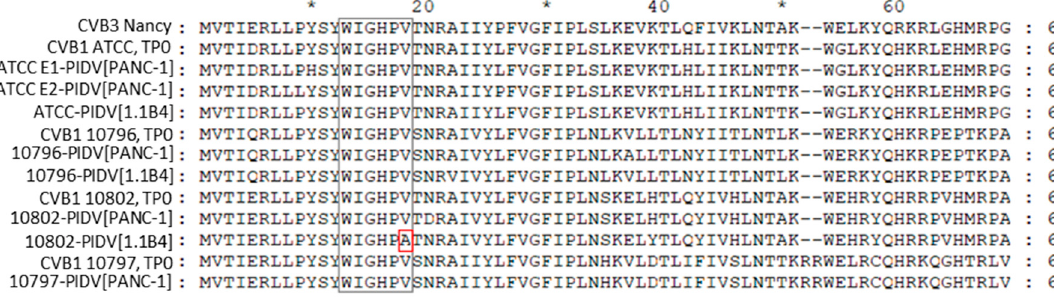
Figure 8. ORF2p and its conserved WIGHPV domain in TP2. One mutation was observed in conserved WIGHPV domain in 10802-PIDV [1.1B4] .